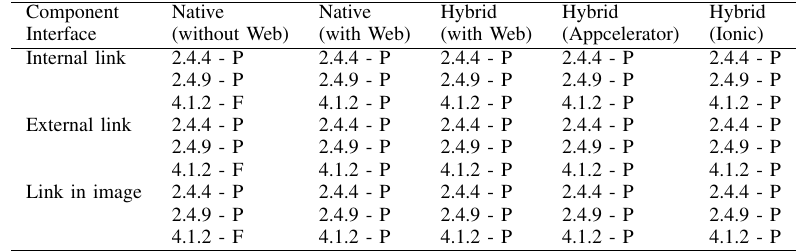
TABLE VI A CCESSIBILITY INSPECTION OF LINKS COMPONENTS